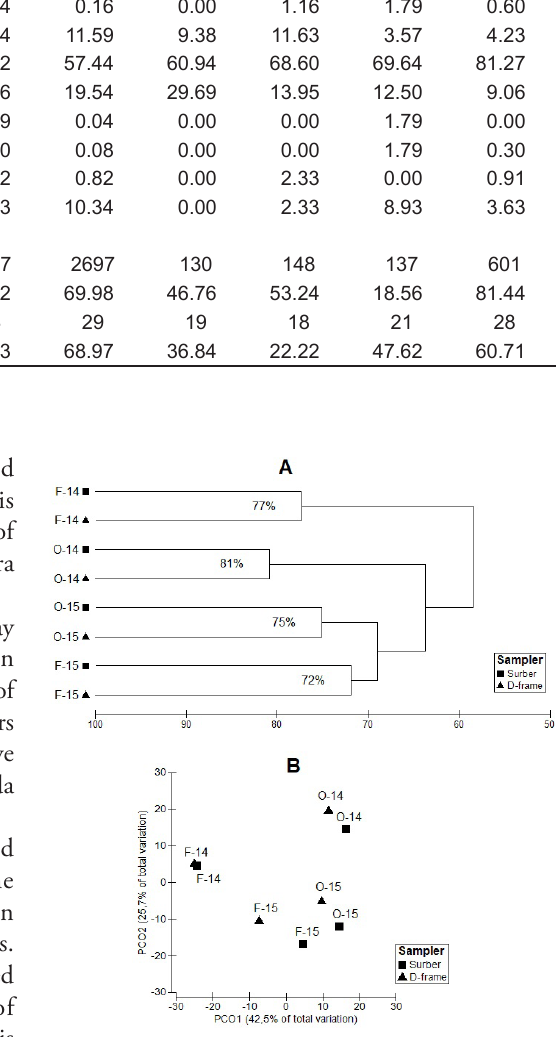
Figure 3. Results of the Hierarchical Clustering analysis (A, with the percentage of similarity grouping the samplers) and Principal Coordinates analysis (B) constructed with data of total OTU’s sampled with Surber and D-frame net in reaches of Itaúna stream with (F-forest) and without (O-open) riparian vegetation, in 2014 and 2015.